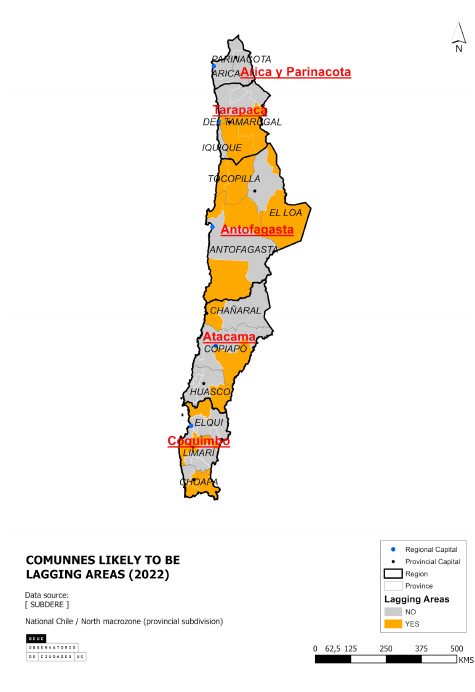
Figure 6: Lag zones by district and province of the northern macrozone of